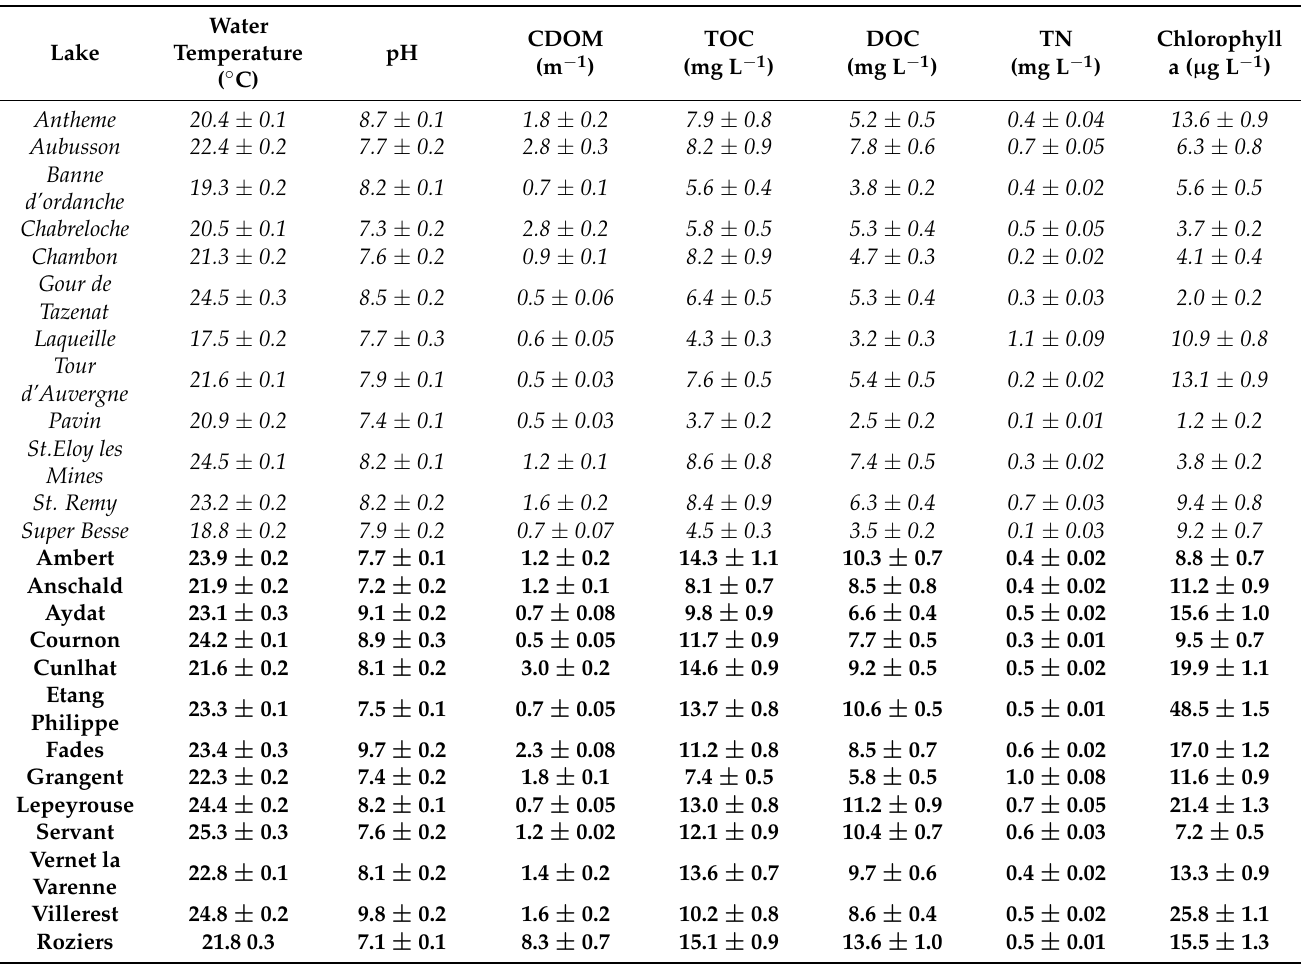
Table 1. Limnological characteristics of the studied lakes grouped according to non-eutrophic (italics) and eutrophic (bold) status. Mean SD (n =